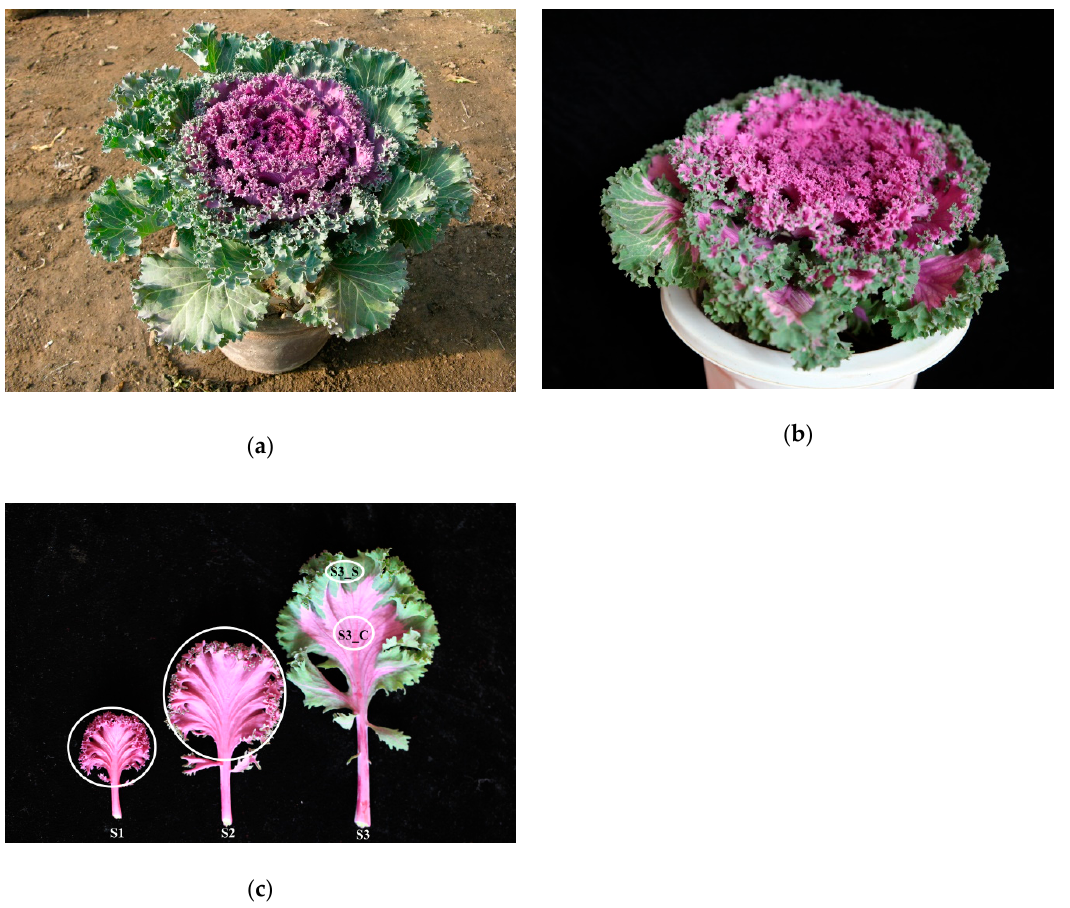
Figure 1. Phenotype of ‘Y005-7’ and the progenitor. ( a ) Phenotype of the progenitor. ( b ) Phenotype of ‘Y005-7’. ( c ) Phenotype of ‘Y005-7’ at the different developmental stages. The green margin at S3 was denoted as S3_S, and the red center was denoted as S3_C. The white circles denote the sampling sites for RNA extraction, pigment, hormone, sugar, and starch content measurement.